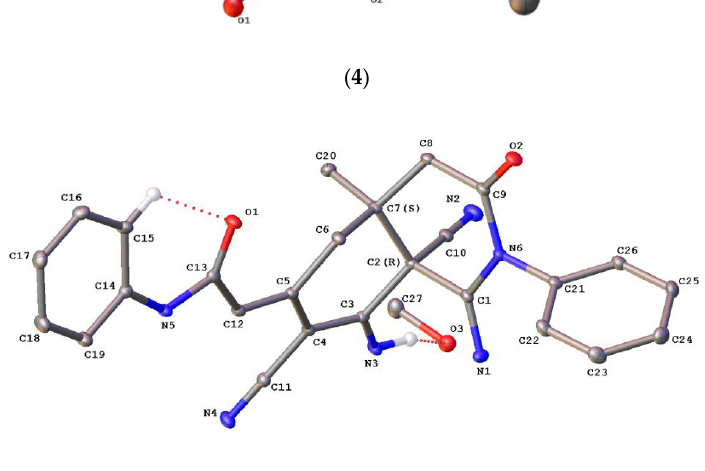
Figure 1. ORTEP plots for compounds 2 , 4, and 9 . Thermal ellipsoids were drawn with 30% of probability. Some hydrogen atoms are removed for sake.